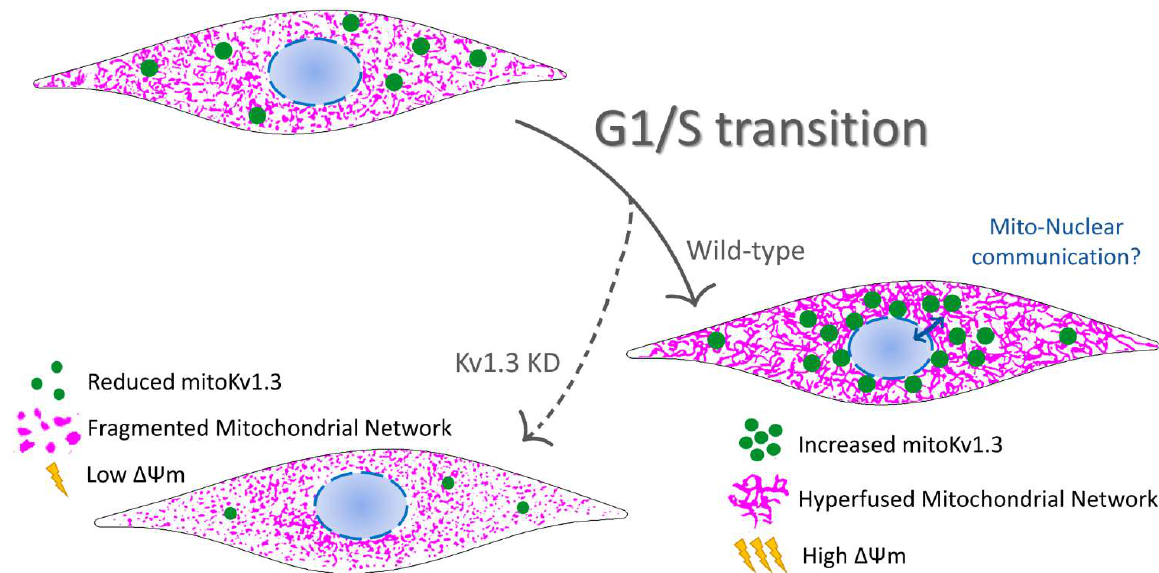
Figure 6. Representative cartoon summarizing the participation of the mitochondrial Kv1.3 (mitoKv1.3) in the proliferation of preadipocytes. Kv1.3 would facilitate the G1/S transition of the cell cycle in preadipocytes accumulating at perinuclear mitochondria. The elucidation of a putative mitochondrial-nuclear communication during this phase of the cell cycle in which Kv1.3 would participate deserves much effort. During the G1/S transition, Kv1.3 would contribute to the mitochondrial fusion/fission equilibrium controlling the mitochondrial membrane potential. Ablation of Kv1.3 (Kv1.3KD) would impair mitochondrial dynamics during cell cycle progression. Kv1.3KD, 3T3-L1 preadipocytes, with a genetic ablation of Kv1.3. Green dots, Kv1.3 channels; magenta, mitochondrial network.